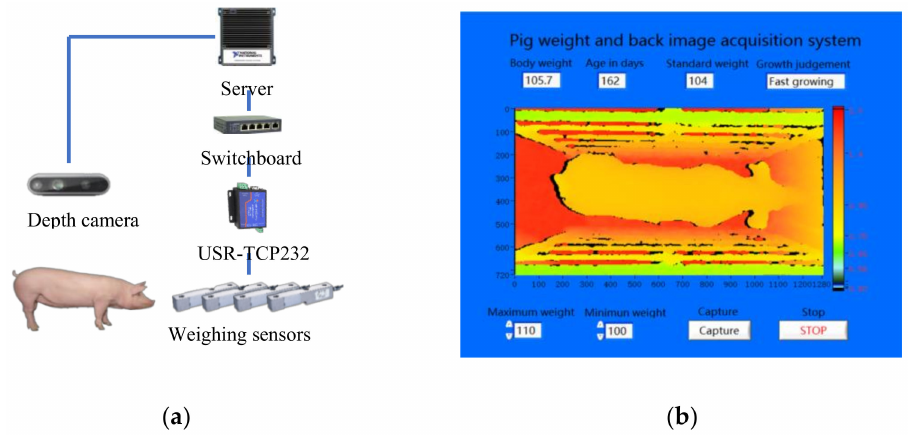
Figure 2. Pig weight and back image acquisition system: ( a ) data acquisition scheme; ( b ) software